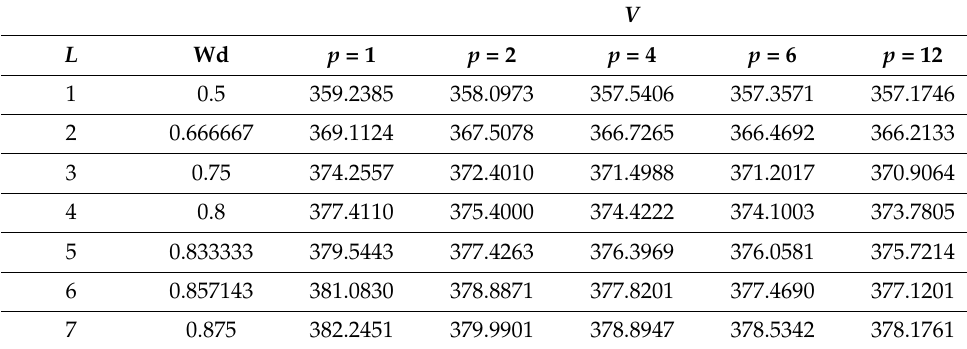
Table 5. The dependence of the company value ( V ) on the leverage level ( L ) of a six-year-old company for advance profit tax payments with frequencies of p = 1, 2, 4, 6 and